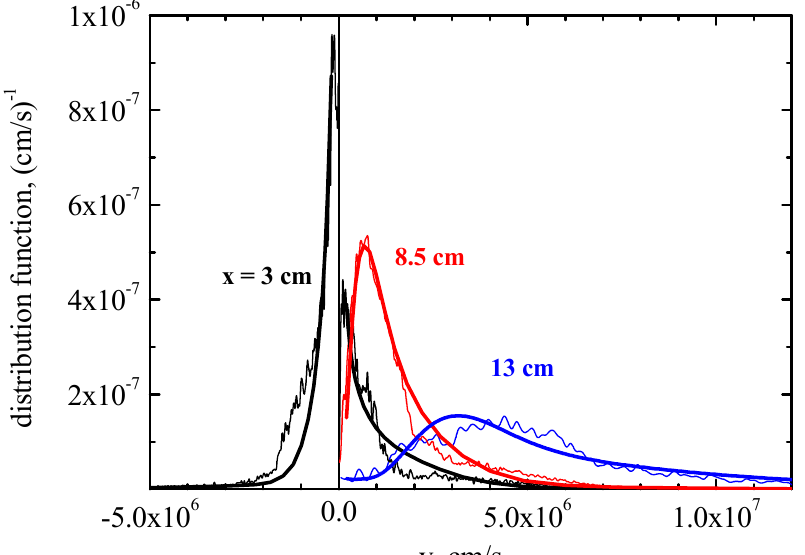
Figure 5. Atomic velocity distribution function at different distances from the wall at the outer horizontal chord: thick solid lines—ballistic model, thin lines—Monte-Carlo simulations with the EIRENE